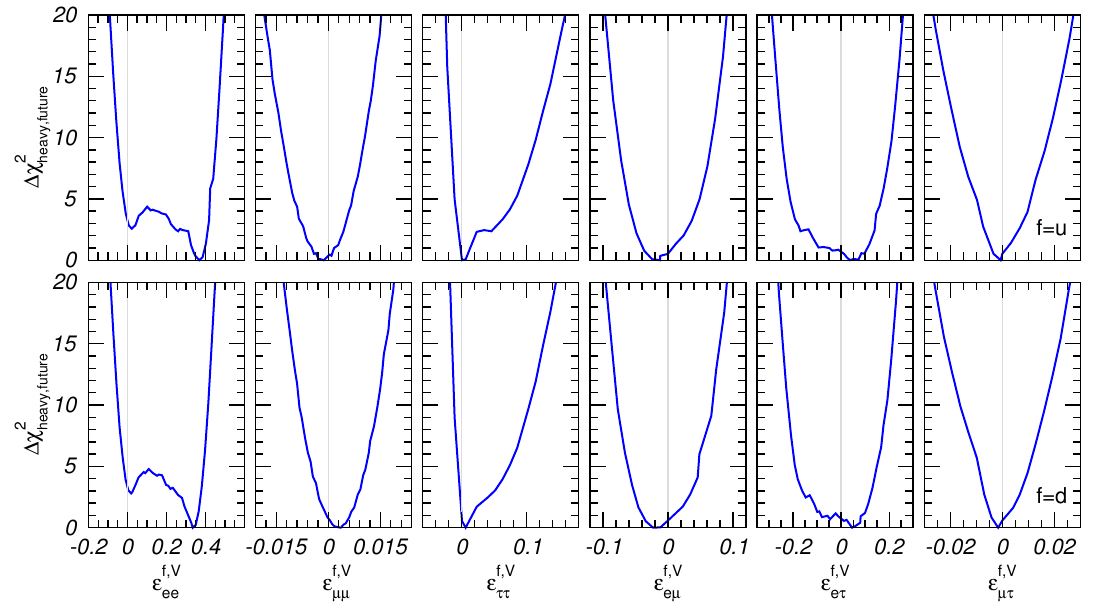
Figure 9 . Dependence of (cid:1) (cid:31) 2 on the NSI parameters (cid:15) f;V for f = u (upper panels) and heavy,future (cid:11)(cid:12) f = d (lower panels), using current global data on oscillations and DIS data from NuTeV and CHARM combined with arti(cid:12)cial COHERENT data generated for all (cid:15) (cid:11)(cid:12) set to zero.